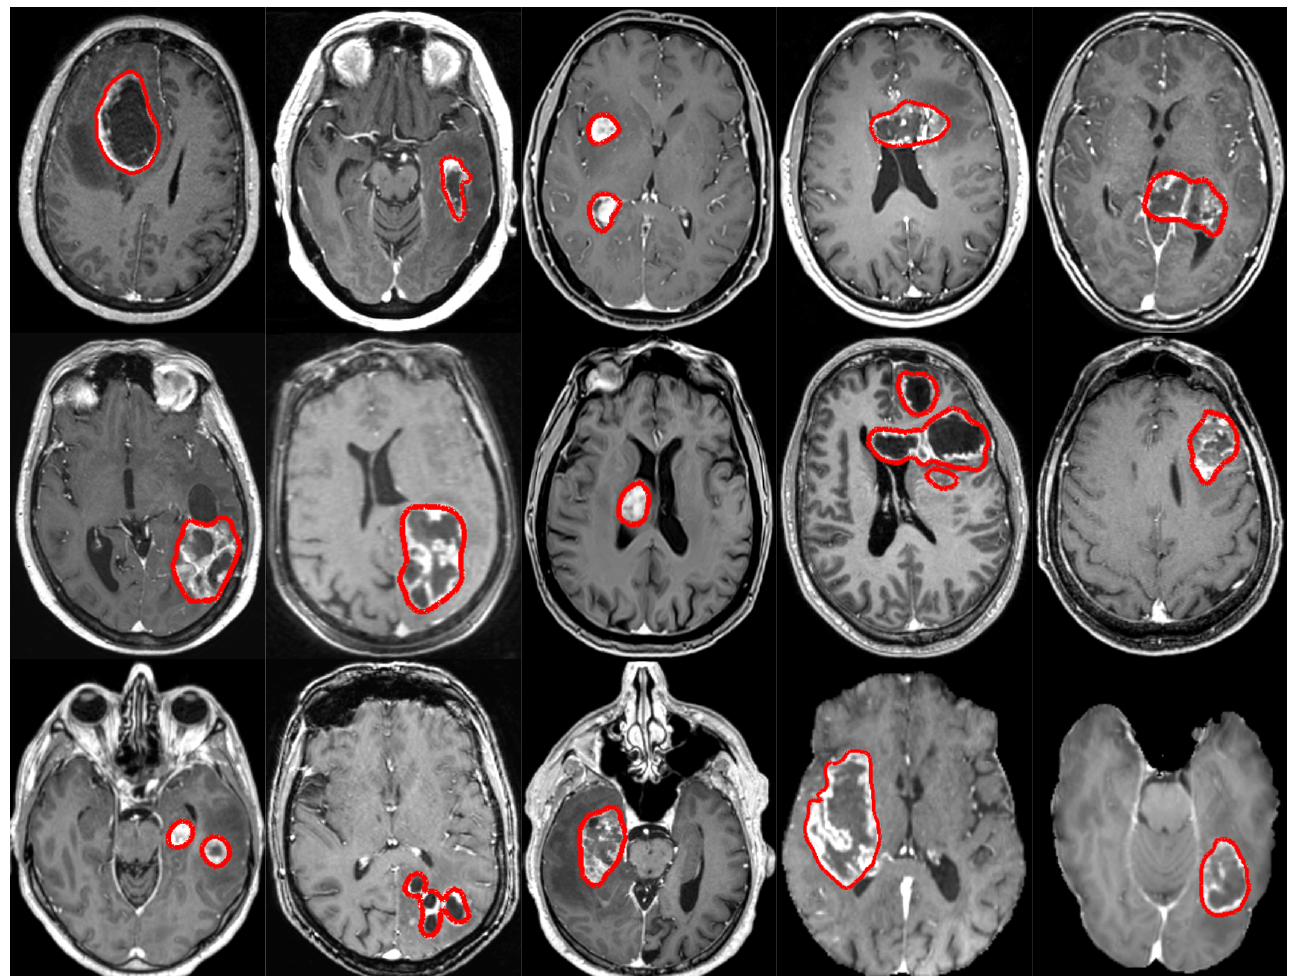
Figure 1. Example axial views of T1-weighted MRI volumes used in the study, with manual segmentations outlined in red. One case from each hospital is shown, and the rightmost two cases featured in the last row are from the BraTS challenge